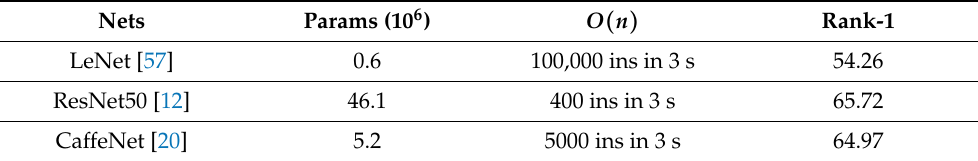
Table 8. The time comparison with existing methods on VIPeR dataset.